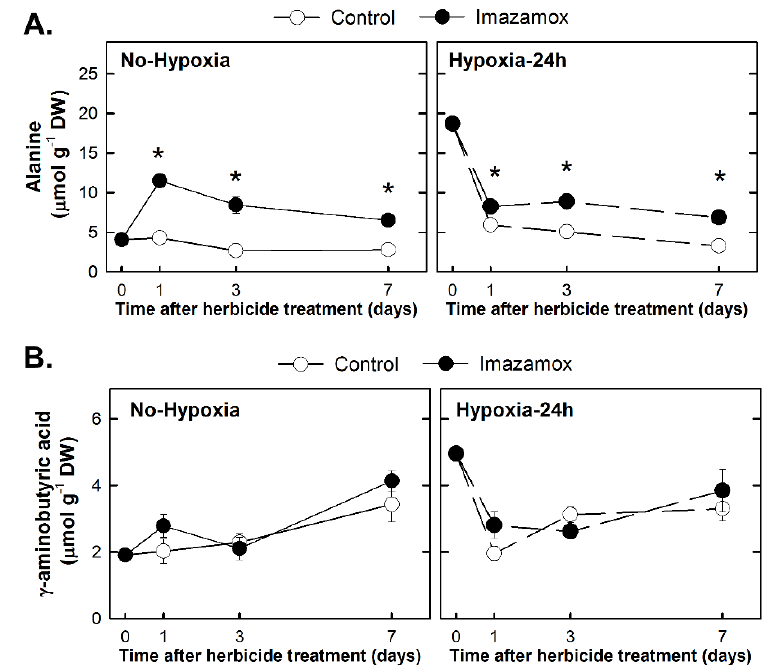
Figure 6. Alanine ( A ) and γ -aminobutyric acid (GABA; B ) contents in the root of pea plants. Pea plants were not treated with hypoxia before herbicide application (Group No-Hypoxia) or were treated with hypoxia for 24 h before herbicide application (Group Hypoxia-24h). Half of the plants from each group were treated with imazamox (5 mg L − 1 , black symbols). In each group, the other halves were not treated with the herbicide and were used as the controls (white symbols) for the imazamox-treated plants. Values represent the mean ± SE ( n = 4 biological replicates). Significant variations are marked with * for differences between control and imazamox-treated plants ( t -Test, p < 0.05) at a given day. See Supporting Information Table S1 for the two-way ANOVA results.